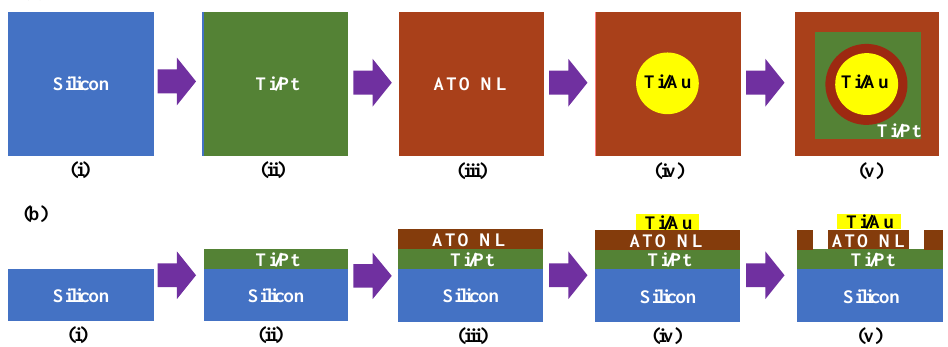
Figure 1. Fabrication routines for the Si/Ti/Pt/ATO NL/Ti/Au capacitors in ( a ) schematic plan view and ( b ) schematic cross-sectional view: (i) silicon substrate cleaning, (ii) Ti/Pt evaporation, (iii) ATO NL deposition, (iv) Ti/Pt evaporation, and (v) ATO NL etching to open the windows for Ti/Pt electrodes.